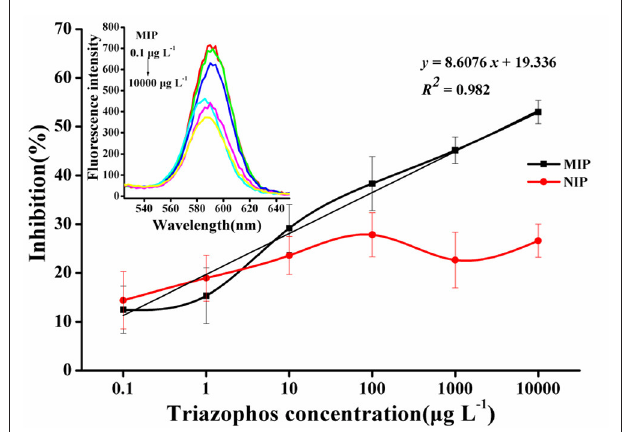
FIGURE 5 | Triazophos BFIA standard curves using the novel imprinted film and the non-imprinted film as an antibody.